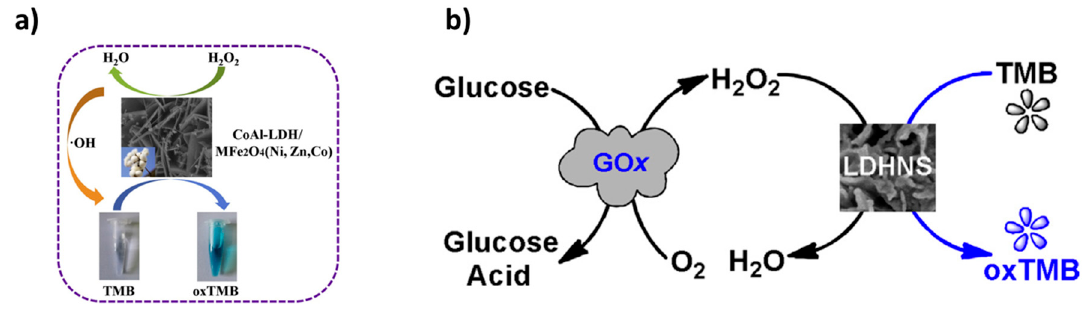
Figure 13. LDH-based peroxidase mimics. ( a ) CoAl-LDH / Fe 2 O 4 hybrid materials catalyze the oxidation of TMB in presence of H 2 O 2 , mimicking the peroxidase activity. Reprinted from Ref. [158] with permission from Elsevier. ( b ) Intrinsic peroxidase-like activity in NiFe-LDH can be leveraged to build up colorimetric sensors for H 2 O 2 and glucose. Reprinted from Ref. [163] with permission from Elsevier.